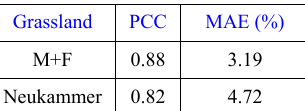
Table 2. Comparison between measured and predicted soil moistures (via forward model computed from Lentzke data). MAE, mean absolute